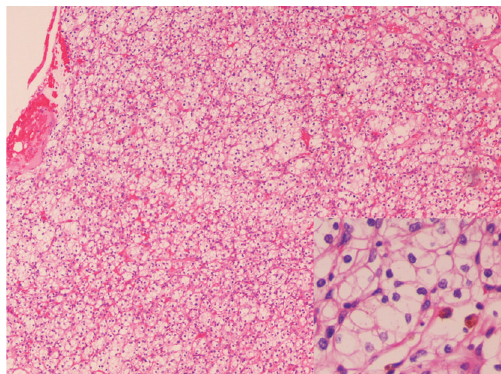
Figure 2: Section of the tumor at the inferior pole of the right kid- ney, showing the classic features of renal cell carcinoma, clear cell type (low power, 10x objective). The cytoplasm is optically clear, and the nuclei are slightly irregular with inconspicuous nucleoli only visible at high power (40x objective, inset) consistent with Fuhrman nuclear grade 2 of